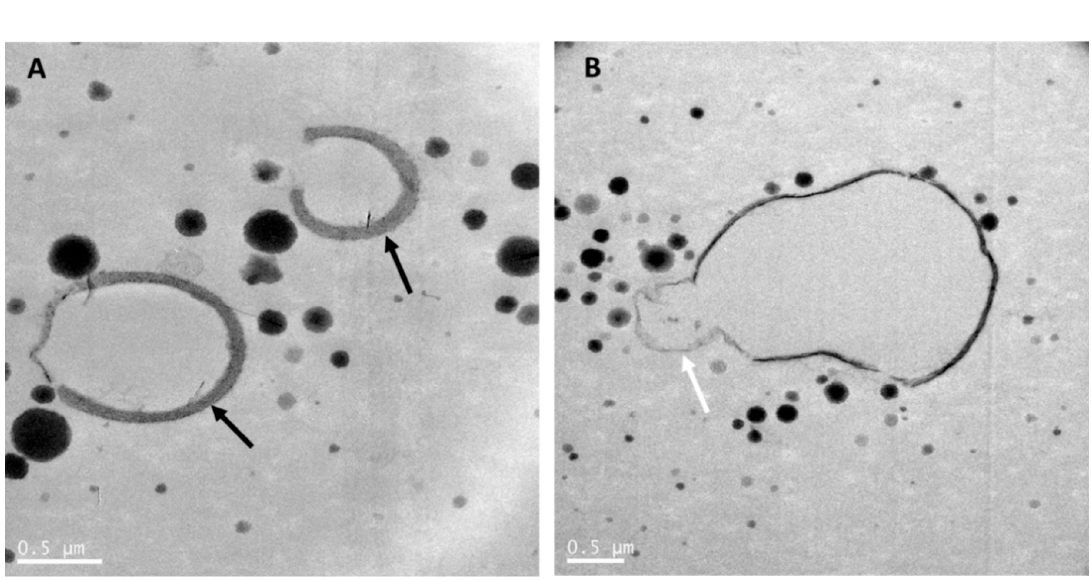
Figure 1. Transmission electron microscopy images of raw goat milk. ( A ) showing goat milk caseins and fat globules with a thick MFGM. ( B ) showing a milk fat globule with a cytoplasmic crescent (white arrow). Black arrows point at the MFGM surrounding fat globules. Goat milk was collected from a single goat in a New Zealand goat farm and kept at room temperature until processing within 2 h using the same method as in Gallier et al. [5]. Scale bar = 0.5 µm.